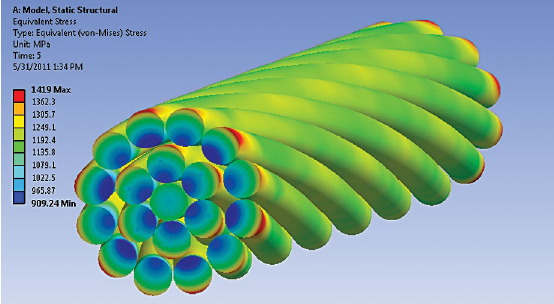
Fig. 15. Diagram of resulting force reaction for 7 × 19 wire